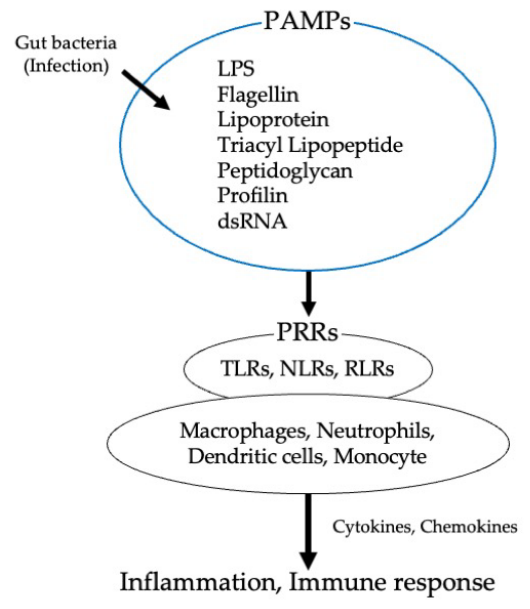
Figure 2. Mechanisms by which gut bacteria induce inflammatory and immune responses via PAMPs and PRRs. PAMPs, pattern recognition receptors; LPS, lipopolysaccharide; PRRs; pattern recognition receptors; TLRs, Toll-like receptors; NLR, NOD-like receptors; RLR, RIG-I-like receptors. Immune cells use the TLRs expressed on the cell surface to recognize bacteria. There are 10 functional TLRs in humans (TLR1–10) and each TLR recognizes and binds to a different PAMP as a ligand. Because gut bacteria are composed of LPS, peptidoglycan, flagellin, and CpG DNA, it is believed that they are recognized by immune cells via TLRs. Peptidoglycan is recognized by TLR2, LPS is recognized by TLR4, flagellin is recognized by TLR5, and CpG DNA is recognized by TLR9. Table 1 presents the exogenous and endogenous ligands of TLRs (Table 1). Mice lacking myeloid differentiation primary- response protein 88 (MyD88), a downstream signaling molecule of TLRs, not only present with low levels of intestinal IgA antibody but also exhibit reduced mucus acidity, intestinal epithelial cell proliferation, and antimicrobial substance production. This indicates the importance of the recognition of gut bacteria by TLRs